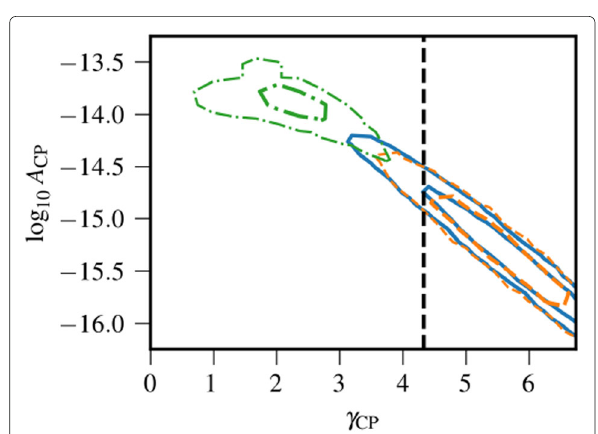
Fig. 4 1 and 2 σ contours of posterior fit to the models described in Fig 4. Green dot dashed curve is not a good model driven by higher frequency noises, while blue broken power-law contours refer to the fit at lower frequencies which is practically identical to the orange broken contours. The vertical broken line marks γ CP = 13 / 3 corresponding to α = − 2 / 3. Reproduced from [30] by permission of the